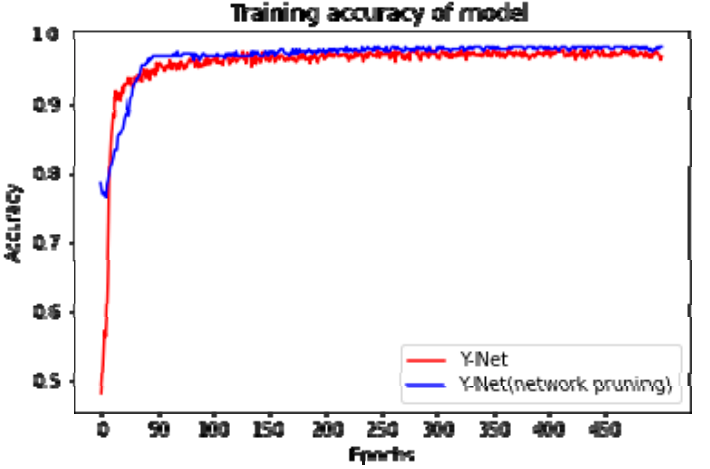
Figure 13. Accuracy of Y–Net before and after pruning.